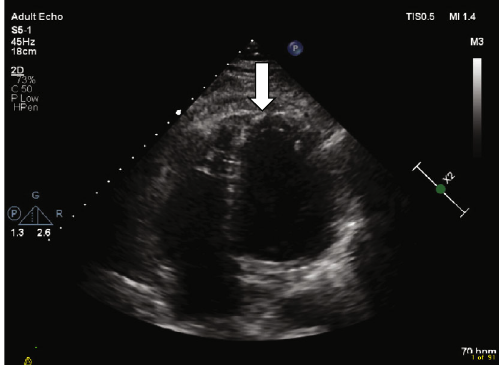
Figure 4: Apical 4 chamber views show pericardial thickening around the apex of left and right ventricles. White arrows; in addition to small pericardial e ff usion.